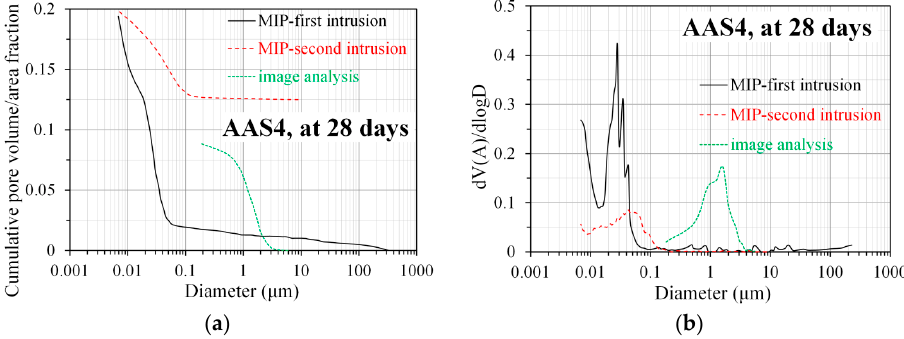
Figure 13. Comparison of the pore size distribution ( a ) and differential curve ( b ), derived from MIP and image analysis, for AAS4 at 28 days. In the graphs, AAS indicates alkali-activated slag, and the number following AAS refers to the weight percentage of Na 2 O with respect to slag. For all samples, the water to slag ratio was 0.4 and the curing temperature was 20 °C.